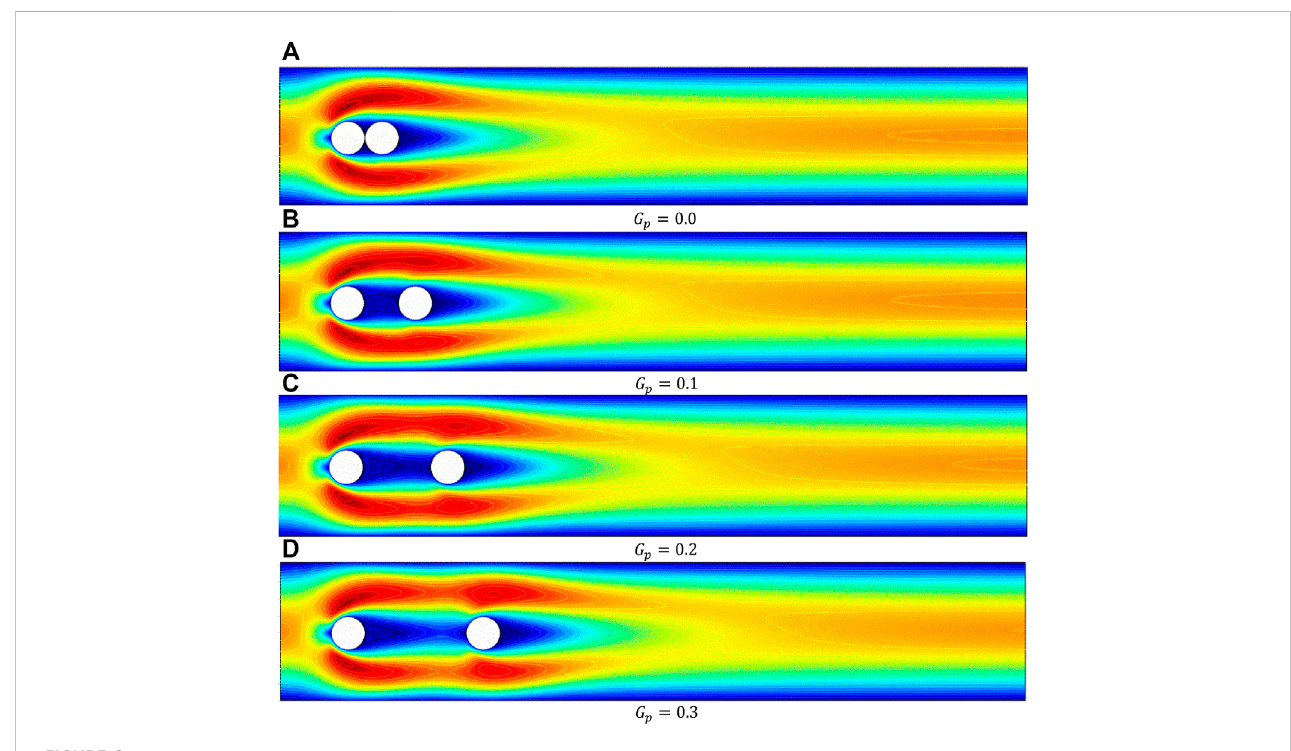
FIGURE 6 In fl uence on velocity for various gap spacings of a cylinder with n (cid:2) 1 and Re (cid:2) 20.